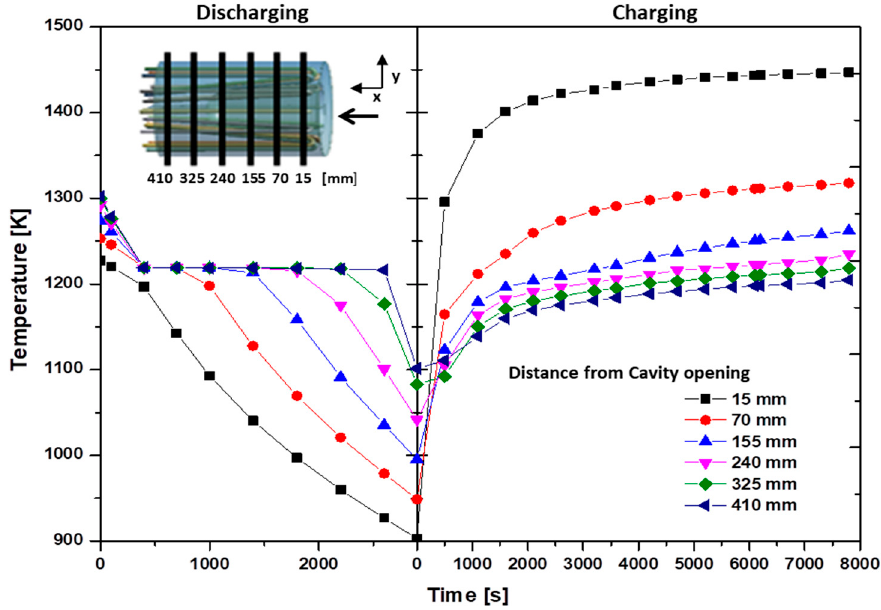
Figure. 9. Average temperatures at several sections along the x-axis.